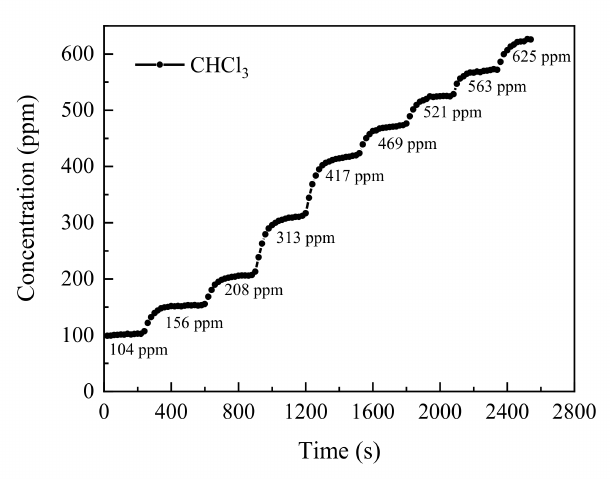
Figure 6. Continuous measurement of the chloroform gas with the concentration gradually increasing from 104 ppm to 625 ppm. The process lasted for over 40